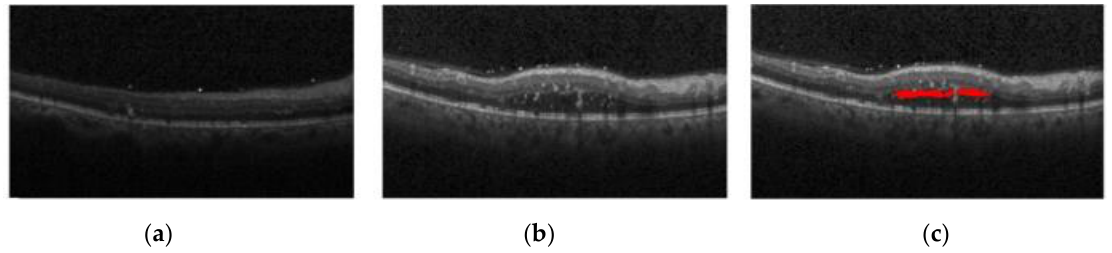
Figure 1. Optical coherence tomography (OCT) images and the annotations of the edema regions: ( a ) normal retina OCT image; ( b ) OCT image with macular edema; ( c ) the annotations of the edema regions.